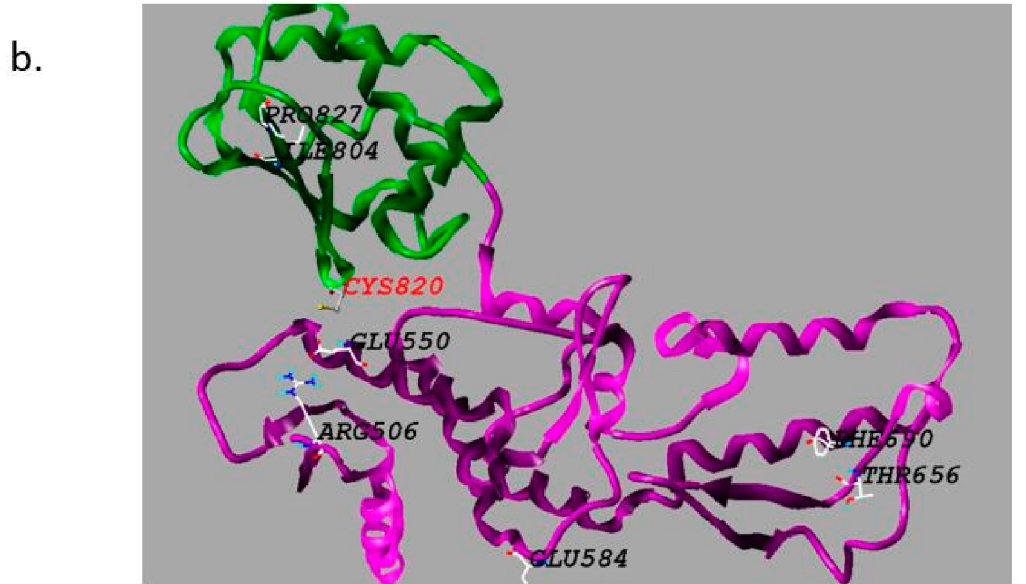
Figure 1. E6AP domains and their therapeutic significance. ( a ) Domains in the primary sequence of E6AP protein. The numbers in parentheses indicate the corresponding amino acid residues of E6AP isoform 1 protein. The C-terminus of E6AP protein has the prototype Homologous to the E6-AP Carboxyl Terminus (HECT) domain. This domain has the E2-binding site and the catalytic center Cys820. E6-binding domain binds the HPV E6 oncoprotein. The Zn-binding Amino-terminal Zn-finger of Ube3a Ligase (AZUL) domain is present at the N terminus. The HERC2-binding domain is required for the association with the partner HECT E3 HERC2. Small molecule inhibitors targeting the E6AP-E6 and E6-p53 interactions that disrupt the E6AP-E6-p53 complex are potential therapeutic strategies for human papillomavirus (HPV). Substitution of Phe727 by N-acetyl phenylalanine inhibits the oligomerization of E6AP essential for its activity. ( b ) Crystal structure of the HECT domain and the locations of Angelman syndrome (AS)-linked missense mutations. The N lobe is colored in magenta and the C lobe is colored in green. The catalytic Cys820 is labeled in red. Hereditary and de novo missense mutations found in the indicated amino acids are thought to be pathogenic in AS patients. The Biopolymer module of Tripos software was used to generate the figure, considering the E6AP part of 1C4z.pdb crystal structure.